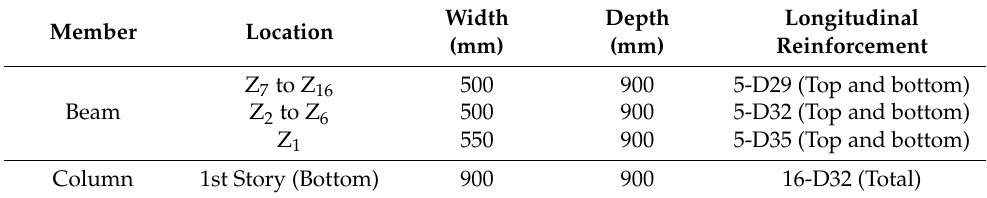
Table A3. Sections at potential hinges of RC members for 16-story model.